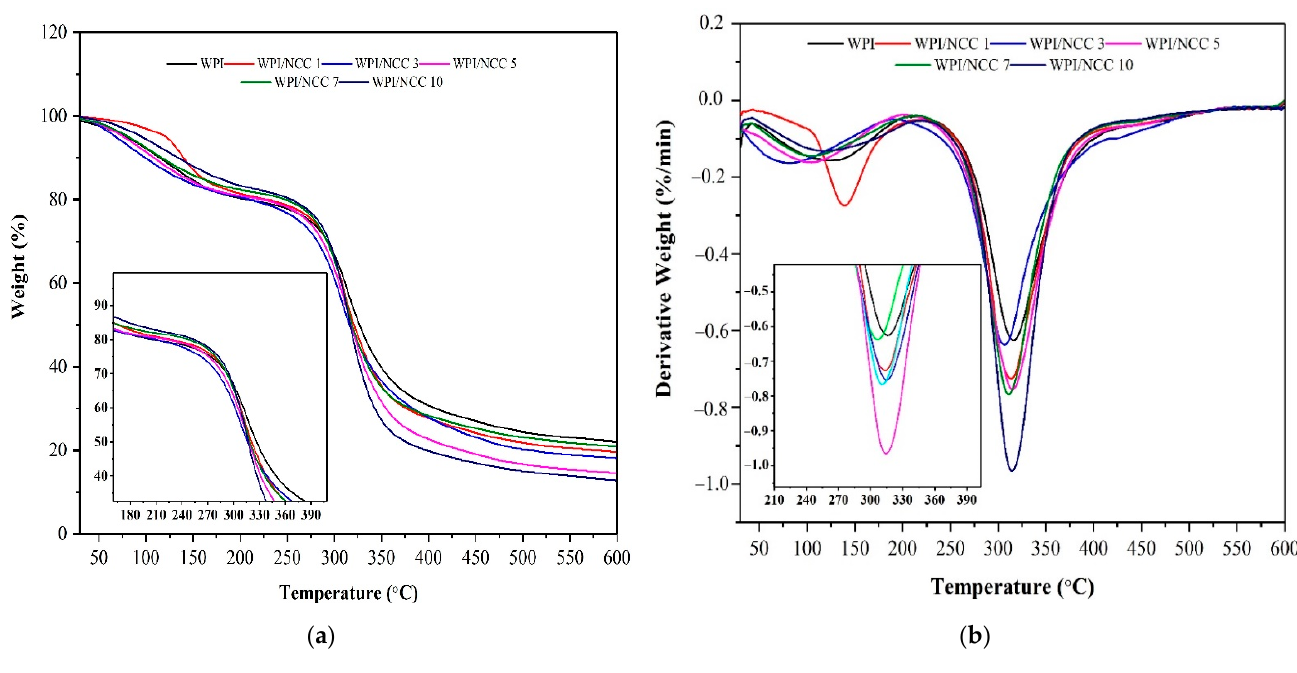
Figure 6. ( a ) TGA and ( b ) DTG biocomposite film.